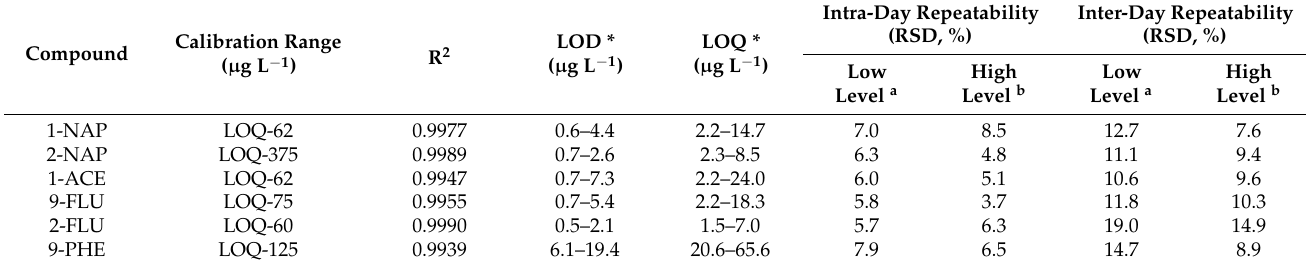
Table 4. Analytical characteristics of the proposed method for OH-PAHs in urine.